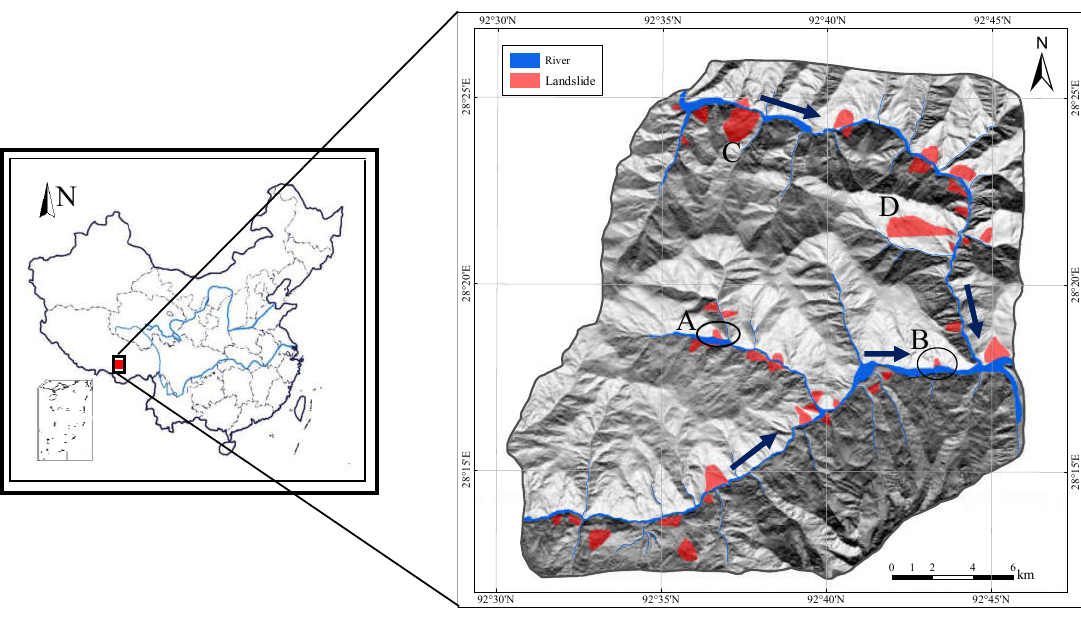
Figure 3. Geographical location of the study area.